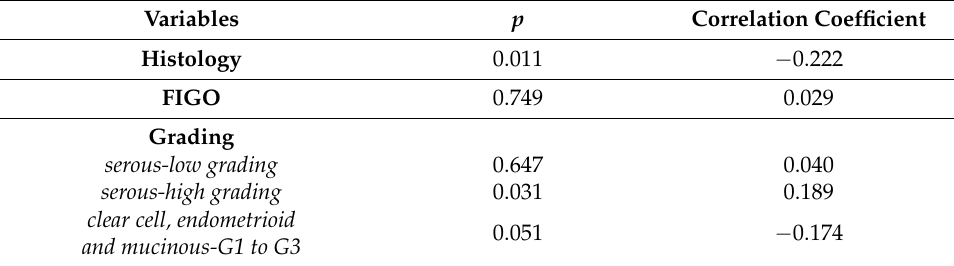
Figure 1. PAFR expression varies in different ovarian cancer subtypes. ( a ) Raised cytoplasmic PAFR staining in serous, ( b ) clear cell, and ( c ) endometrioid cancer cells compared to the ( d ) mucinous subtype. ( e ) PAFR positive and ( f ) PAFR negative control in the kidney. ( g ) The mucinous subtype demonstrates a significantly lower cytoplasmic PAFR staining expression compared to the other histological subtypes ( p = 0.000) as analyzed by one-way ANOVA test and shown as *** p ≤ 0.001. Two patient outliers are indicated (148, 149). Table 2. Correlation analysis between positive cytoplasmic PAFR expression and clinicopathological